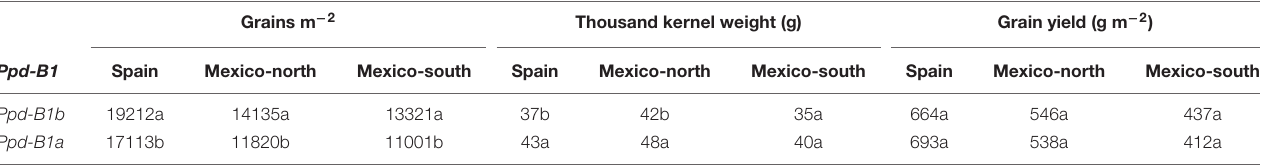
TABLE 6 | Mean values for yield components for each Ppd-B1 allele.